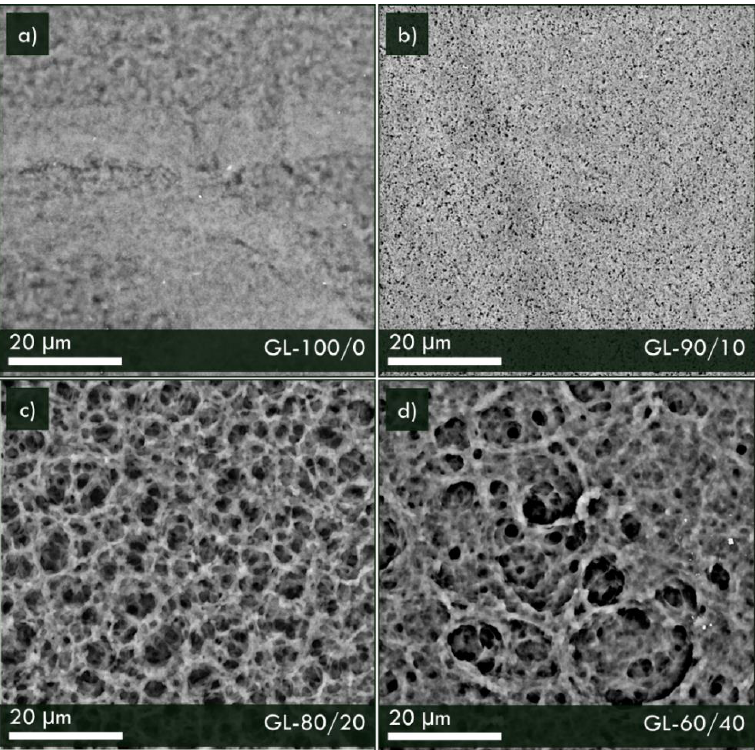
Figure 6 . SEM images of top surfaces of composite membranes: ( a ) GL-100/0, ( b ) GL-90/10 ( c ) GL- 80/20 and ( d ) GL-60/40 samples.